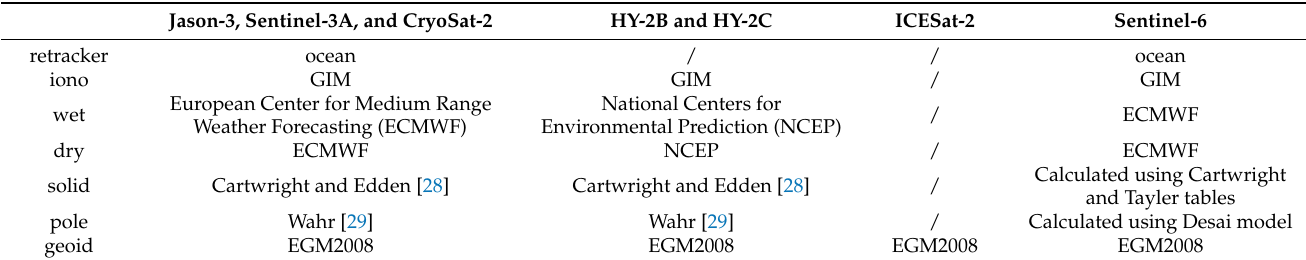
Table 3. Sources of the main parameters for altimetry measurement.